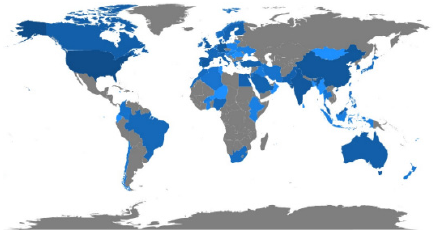
Figure 8. Country Scientific Production (LCOE).